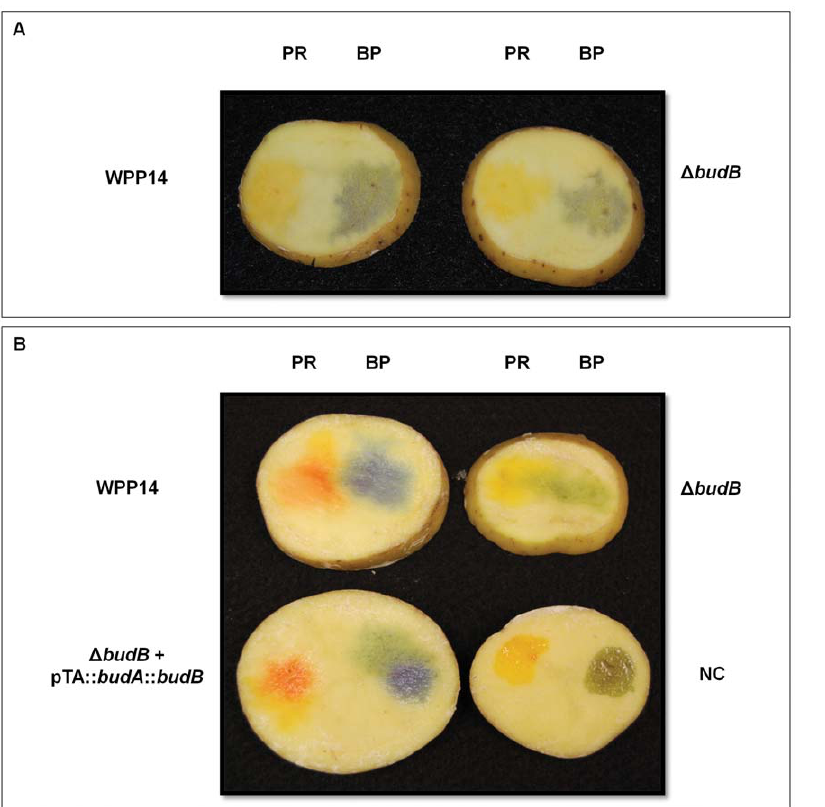
Figure 3. The P.c. subsp. carotovorumbudAB operon affects bacterial modification of pH in tubers slices that are incubated anaerobically. Potato slices were inoculated with 10 6 CFU and incubated under aerobic ( A ) and anaerobic conditions ( B ) for 20 hours at room temperature ( , 22 u C). PR : pH indicator phenol red (yellow at pH below 6.4 and red violet at pH above 8.2), BP : pH indicator bromocresol purple (yellow at pH below 5.2 and purple at a pH above 6.8).